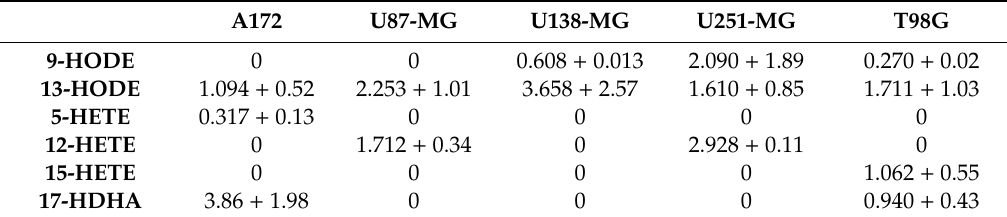
Table 1. Oxylipins produced by the lipoxygenase pathway in cultured glioblastoma (GBM) cell lines